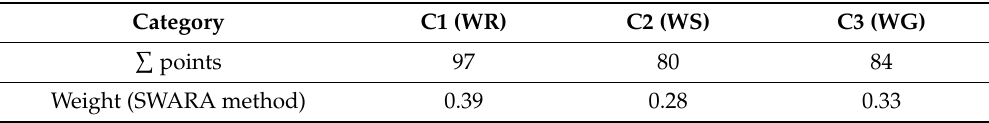
Figure 5. Experts’ opinion about the importance of water governance indicators: C3.1: roles and responsibilities (RR), C3.2: access to water information (AWI), C3.3: stakeholder engagement (SE). Table 24. Determination of weights of water resources (WR), water services (WS) and water governance Table 23. Determination of weights of water governance indicators. (WG)